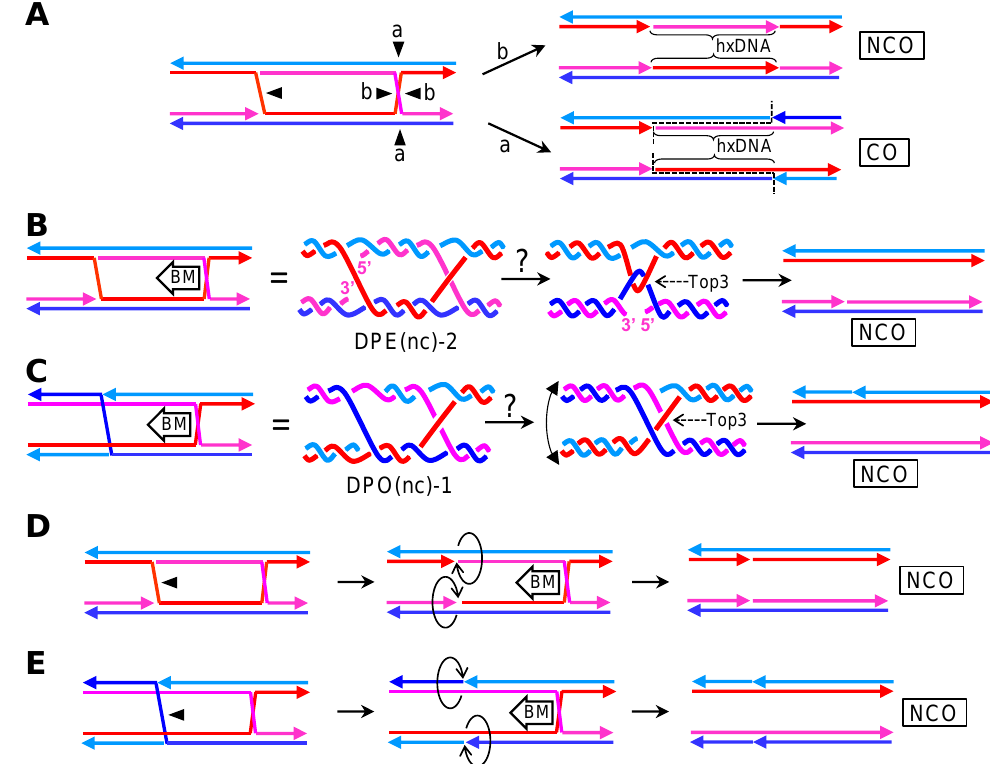
Figure 6. Features of a double Holliday junction formed by a canonical and a nicked Holliday junction (dcnHJ). ( A ) Resolution of a DPE dcnHJ isomer. The NCO or CO product depends on the cutting plane of the cHJ (“a” or “b”). In both cases a short-tract of hxDNA spans between the resolved HJs. ( B ) Dissolution of a DPE dcnHJ by branch migration of the cHJ towards the nHJ. A final Top3-mediated ssDNA decatenation reaction appears necessary. An NCO product without hxDNA and with one single nicked strand is expected. ( C ) Dissolution of a DPO dcnHJ by branch migration of the cHJ towards the nHJ. Top3-mediated ssDNA decatenation could also be necessary. A similar NCO product is expected. ( D – E ) The dcnHJ can be eliminated through nHJ resolution (black arrowhead) followed by branch migration of the cHJ towards the resulting two opposing nicks. Branch migration might be favored by the absence of positive supercoiling ahead because nicks would enable strands swirling (arched arrows). The NCO product carries two opposing nicks, footprinting the original strands involved in the cross-join. A DPE dcnHJ is shown in ( D ), and a DPO dcnHJ in ( E ).